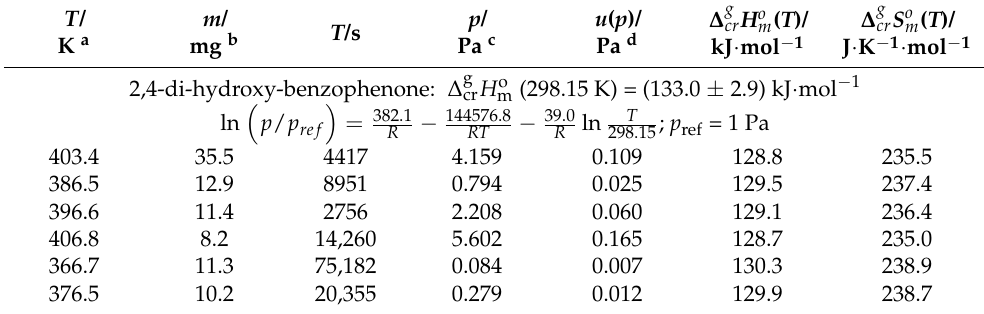
Table 2. Results of Knudsen effusion method for benzophenone derivatives: absolute